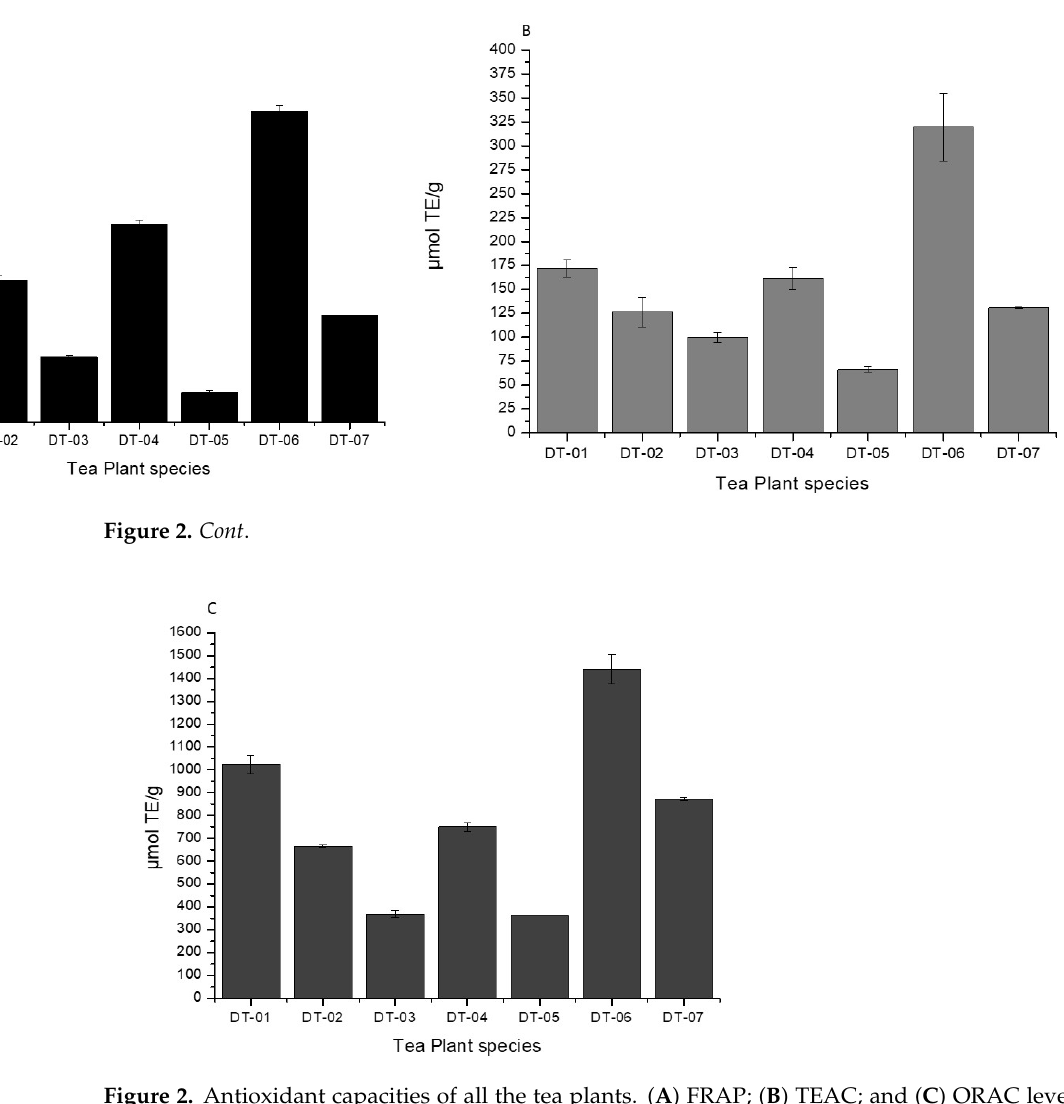
Figure 2. Antioxidant capacities of all the tea plants. ( A ) FRAP; ( B ) TEAC; and ( C ) ORAC levels. n =